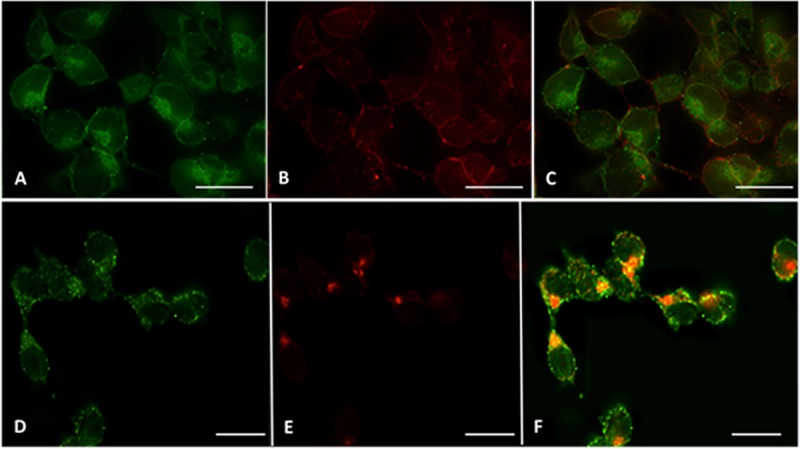
MagA is mainly localized in the intracellular compartment.P19 cells stably expressing MagA-HA were sequentially probed first with primary goat α-HA and secondary Alexa Fluor 488 conjugated-donkey α-goat Ig (A, D, green fluorescence) and then with either Alexa Fluor 594-conjugated WGA (B, red fluorescence) or primary mouse α-p115 and secondary Alexa Fluor 594-conjugated donkey α-mouse Ig (E, red fluorescence). Merging panels A and B revealed only mild yellow fluorescence (C) at the plasma membrane. However, merging panels D and E revealed clear yellow fluorescence (F) wherever MagA-HA and p115 co-localized in the Golgi Apparatus. Scale bar = 15 μm.